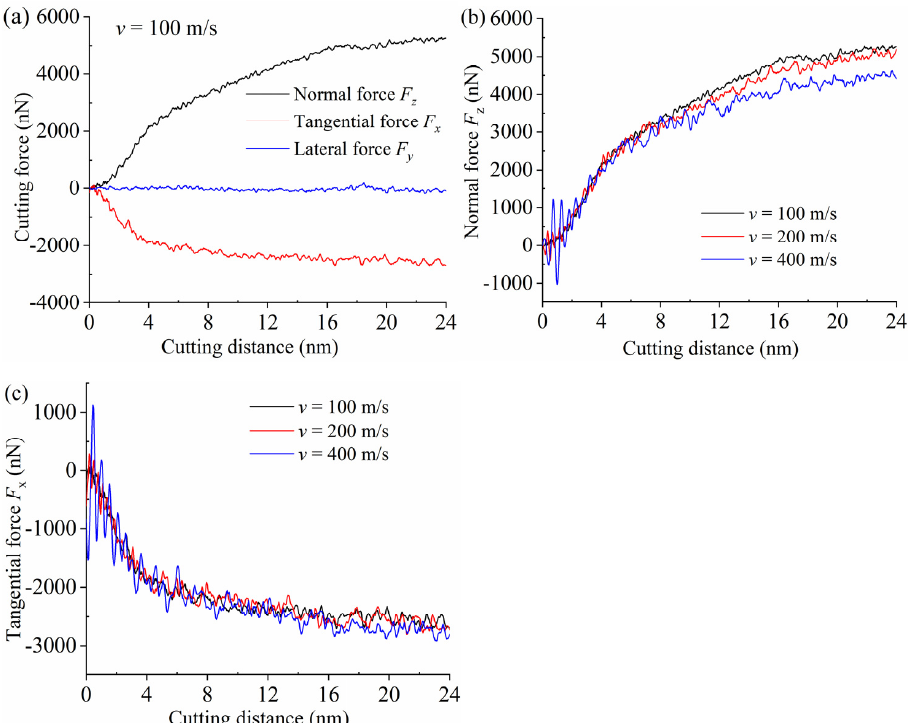
Figure 7. The analysis results of cutting forces at different cutting speed. ( a ) Cutting force; ( b ) Normal force; ( c ) Tangential force.